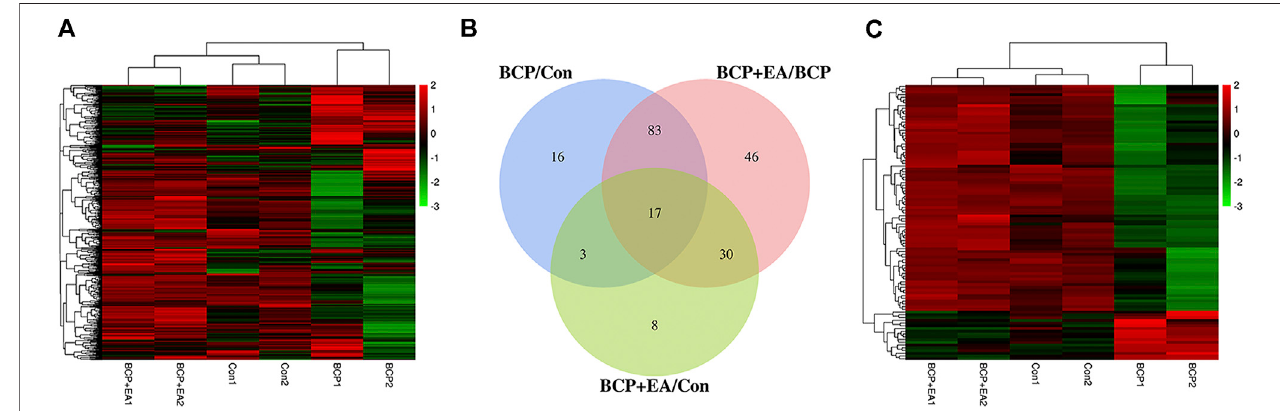
FIGURE3| Phosphoproteomicpro fi leofratDRGsdetectedbythephosphor-explorerarrayPEX100assay.( A) Heatmapillustrationofhierarchicalclusteringofoverall phosphoproteomic pro fi le of DRGs in rats. (B) Venn diagram showing DEPs in DRGs between different groups. BCP/Con stands for DEPs between the BCP and control groups, and the others are in a similar fashion. (C) Heat map illustration of hierarchical clustering of DEPs between groups. Con: Control; DRGs: dorsal root